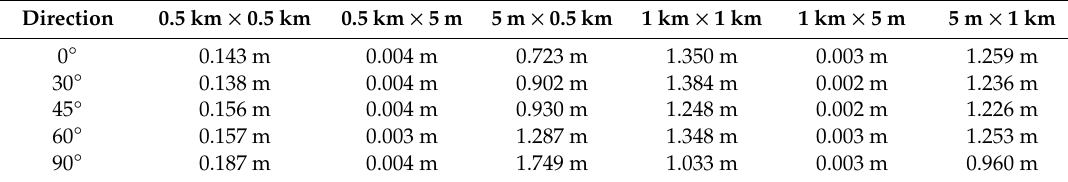
Table 14. The RMS of smoothing velocity bunching phase results with di ff erent swell propagation directions (the direction of the smoothing window is in two directions at the same time, in the azimuth and in the range).